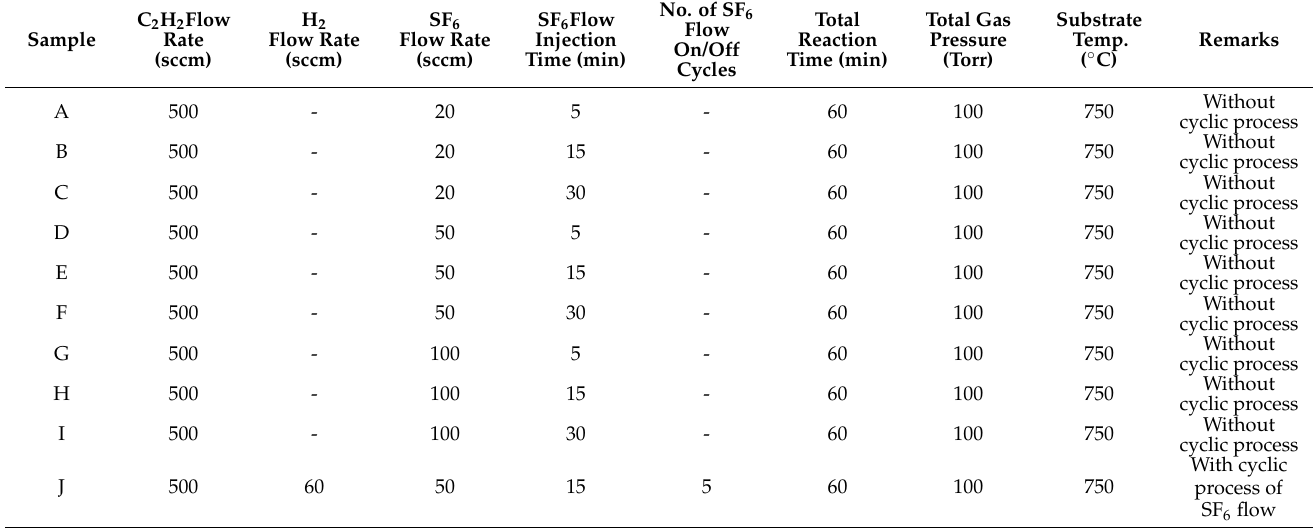
Table 3. Experimental conditions for Samples A–J.